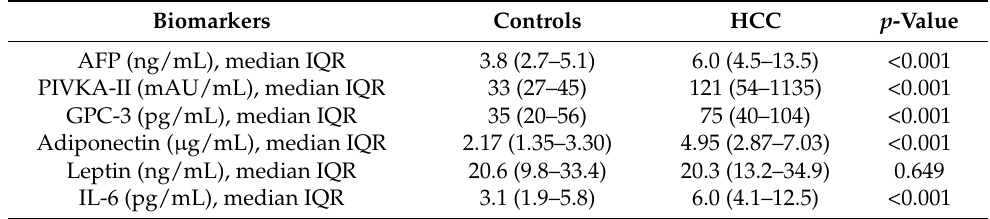
Table 2. Median biomarker levels according to the presence of HCC.